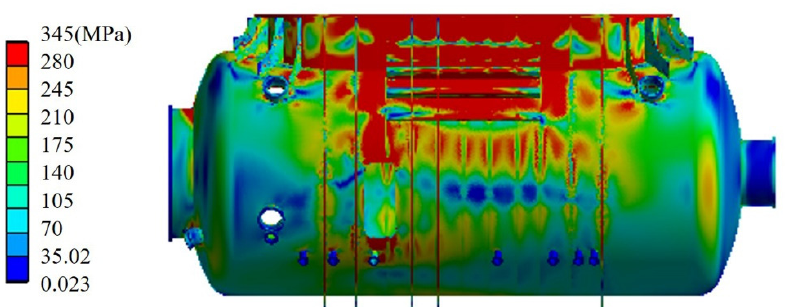
Figure 14. Contours of the von Mises stress distribution of the test cabin under the limit load after the T-ribs are applied.